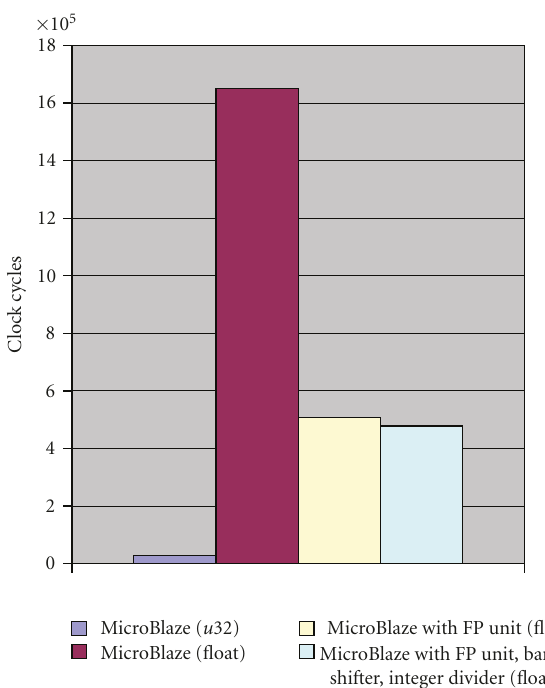
Figure 5: Execution time of the algorithm on a MicroBlaze with di ff erent configurations of the MicroBlaze core.